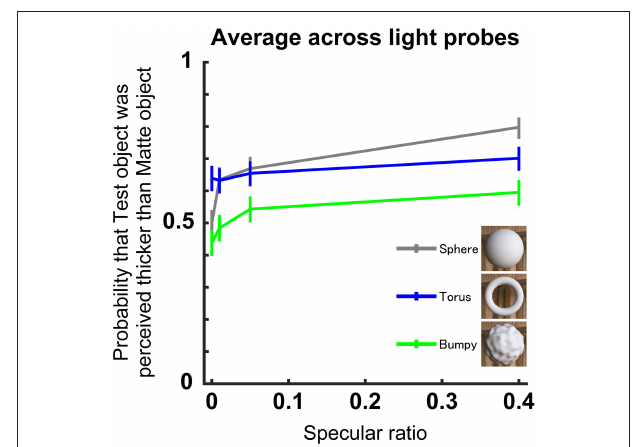
FIGURE 4 | Perceived thickness for different 3D geometry of the object. Format is the same as in Figure 3A . Each line denotes a different 3D geometry, and the averages were computed across the three light probes and observers ( n = 9). Inset shows the appearance of the three matte shapes illuminated using the Dining light